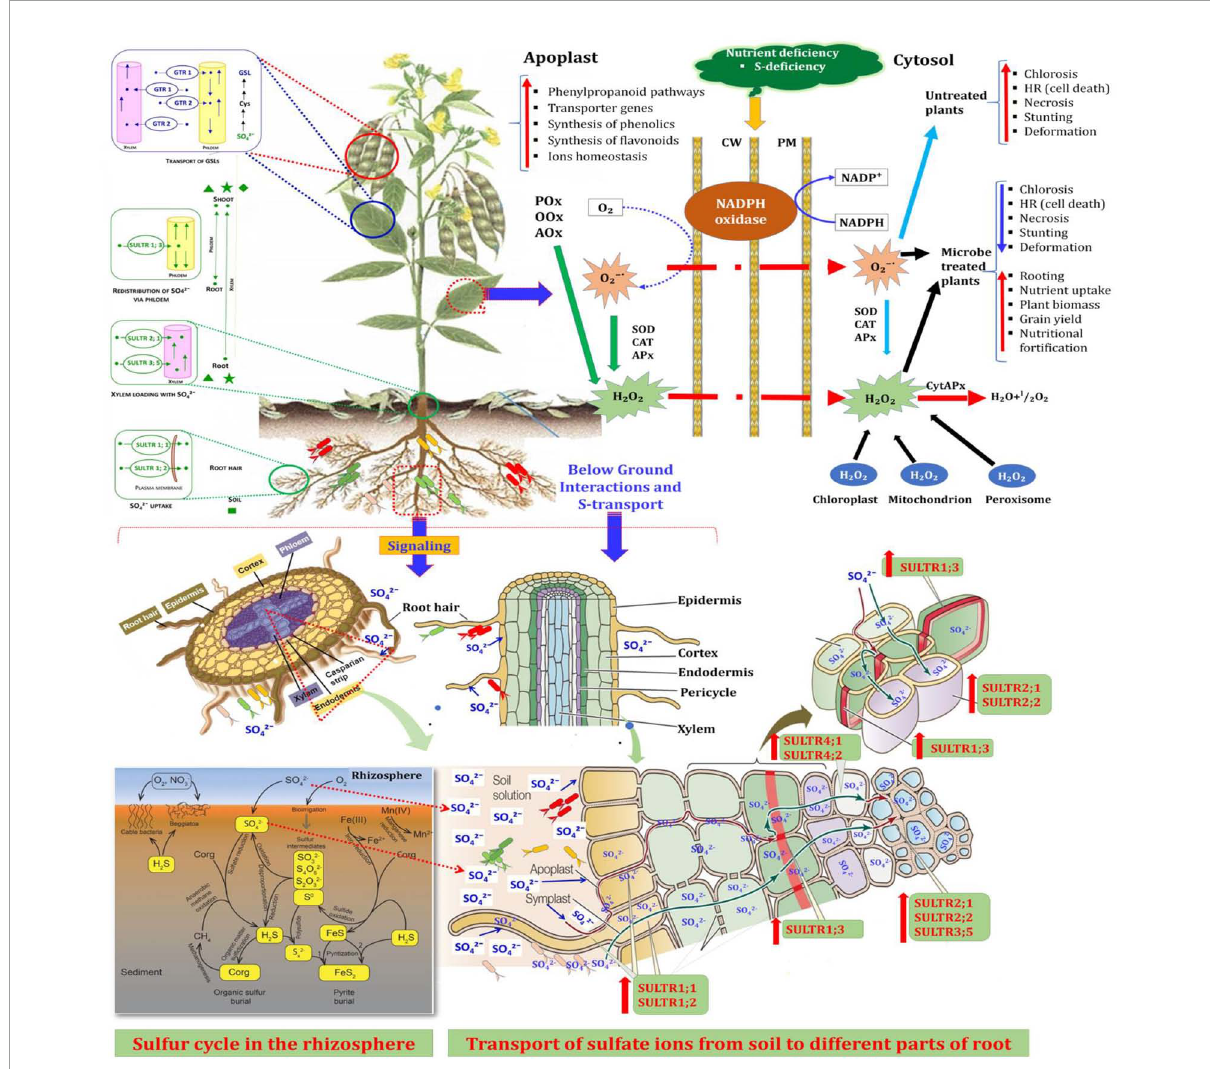
FIGURE10 A comprehensive overview of plant-microbe interactions contributing to S-uptake in plants The oxidation of sulfur to sulfate by SOB in rhizosphere, its uptake by roots and its transport to shoots through involvement of S-transporter genes. The interaction results changes in the activity of radical scavenging enzymes and led to increase in growth and yield of